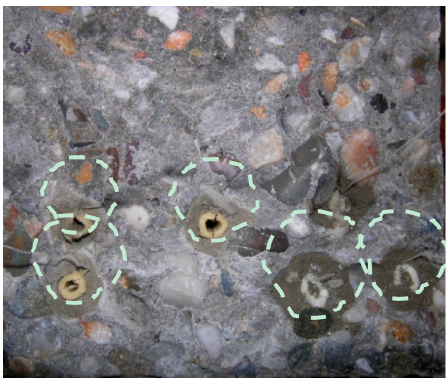
Figure 1. Concrete fractured surface after bending with the embedded starch-based capsules, the dotted line marks the zone surrounding the capsules.